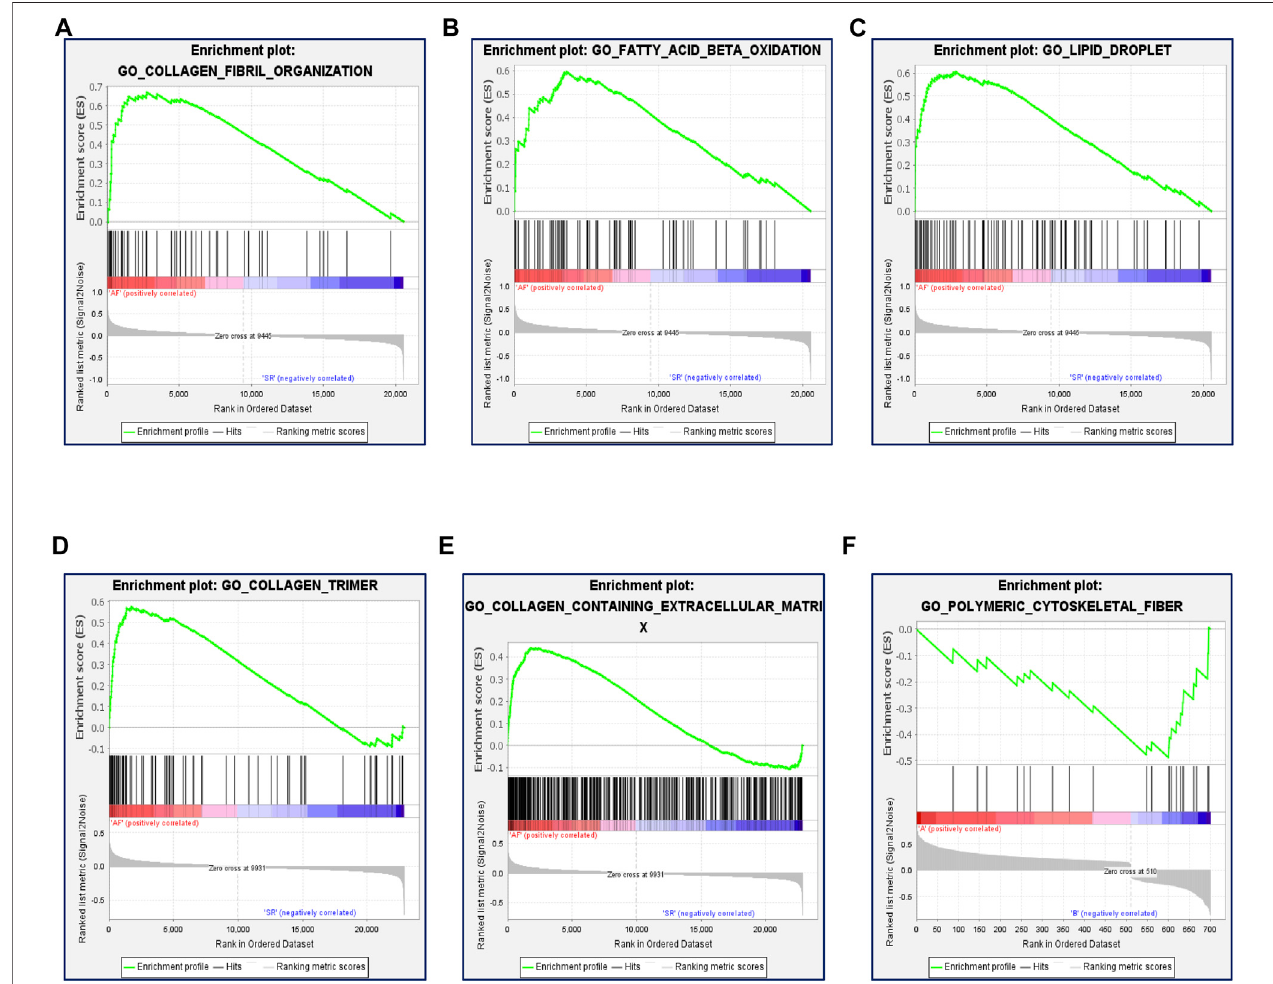
FIGURE 4 | Function enrichment analysis of DEGs by GSEA. (A) Enrichment plot: GO_COLLAGEN_FIBRIL_ORGANIZATION. (B) Enrichment plot: GO_FATTY_ACID_BETA_OXIDATION. (C) Enrichment plot: GO_LIPID_DROPLET. (D) Enrichment plot: GO_COLLAGEN_TRIMER. (E) Enrichment plot: GO_ COLLAGEN_CONTAINING_EXTRACELLULAR_MATRIX. (F) Enrichment plot: GO_POLYMERIC_CYTOSKELETAL_FIBER.